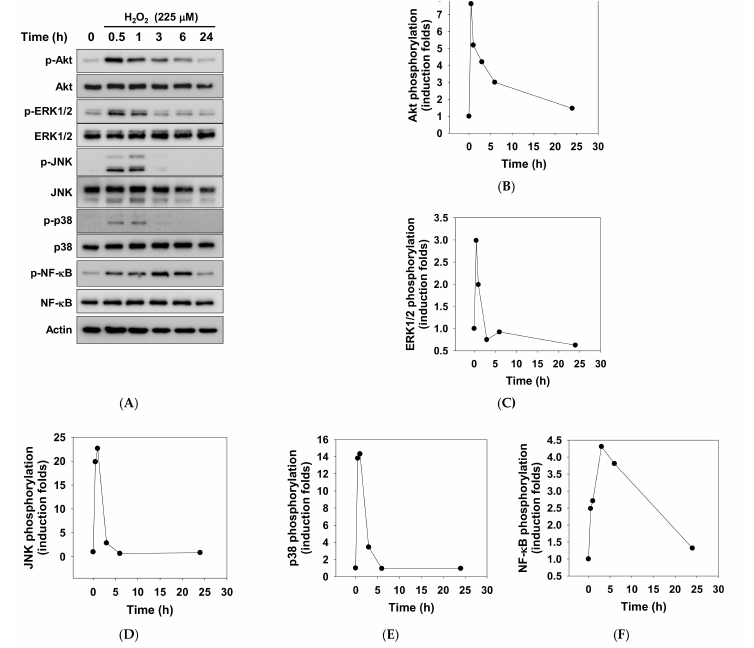
Figure 2. Characterization of hydrogen peroxide-driven signaling kinetics in human ARPE-19 cells. ( A ) ARPE-19 cells were treated with 225 µ M of H 2 O 2 for the indicated time. Cellular protein lysates were subjected to western blotting detection for total and phosphorylated kinase proteins. Densito- metric analysis was used to quantify phosphorylation levels of Akt ( B ), ERK1/2 ( C ), JNK ( D ), p38 MAPK ( E ), and NF- κ B ( F ). Data are expressed as mean values from three independent